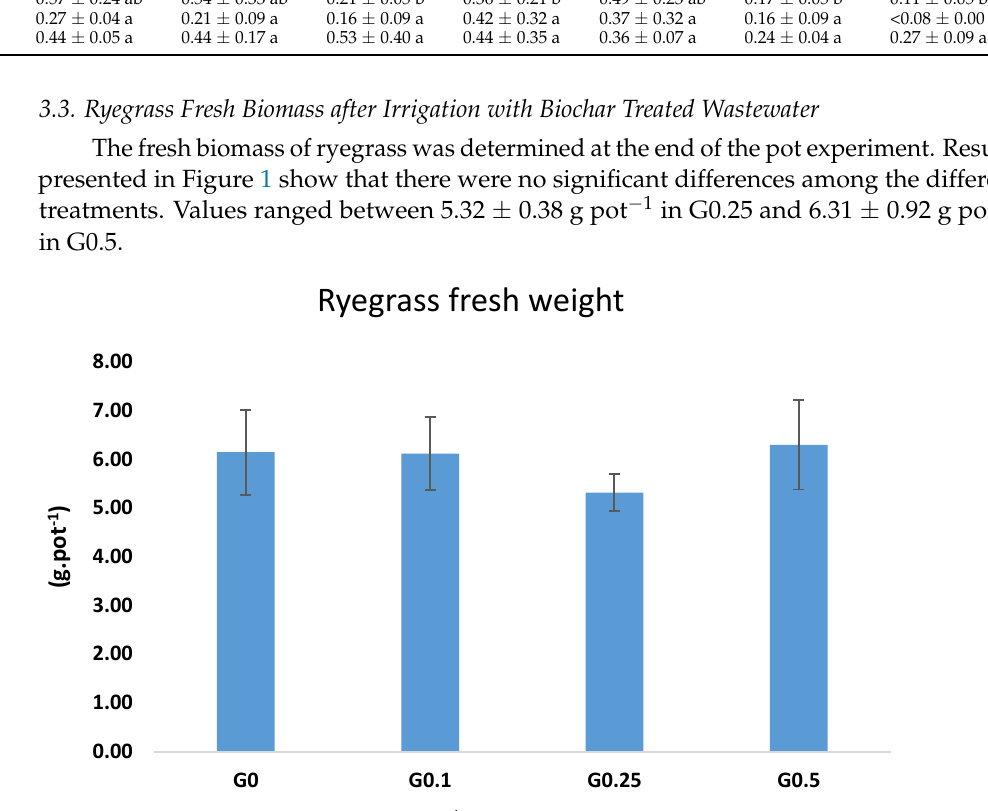
Figure 1. Ryegrass fresh weight (g pot − 1 ) in soils (G0, G0.1, G0.25, G0.5) after irrigation by the biochar-treated wastewater at different concentrations (0, 0.1, 0.25 and 0.5 g L − 1 ). Values represent means ± standard deviations ( n = 4, p ≤ 0.05) .